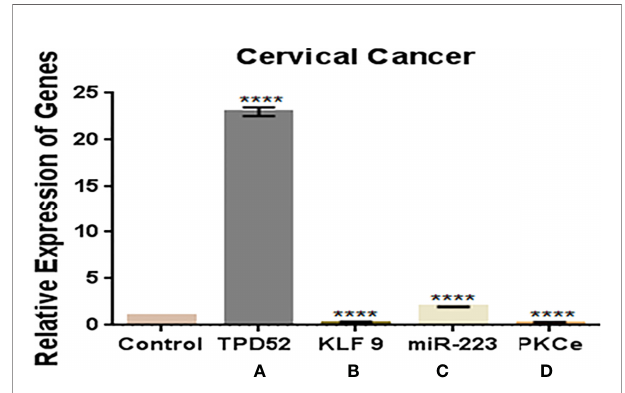
FIGURE 6 | Expressions of TPD52 , KLF9 , miR-223, and PKC ϵ in blood of cervical cancer patients. (A) TPD52 expression was increased 23-fold. (B) KLF9 expression was decreased 0.4-fold. (C) miR-223 expression was increased 2-fold. (D) PKC ϵ decreased 0.05-fold. Fold change is plotted on the y -axis and study groups on the x -axis. Illustrative data are presented as the mean ± SEM of triplicate experimentations. Statistical signi fi cance was measured by ordinary two-way ANOVA (**** p < 0.0001).